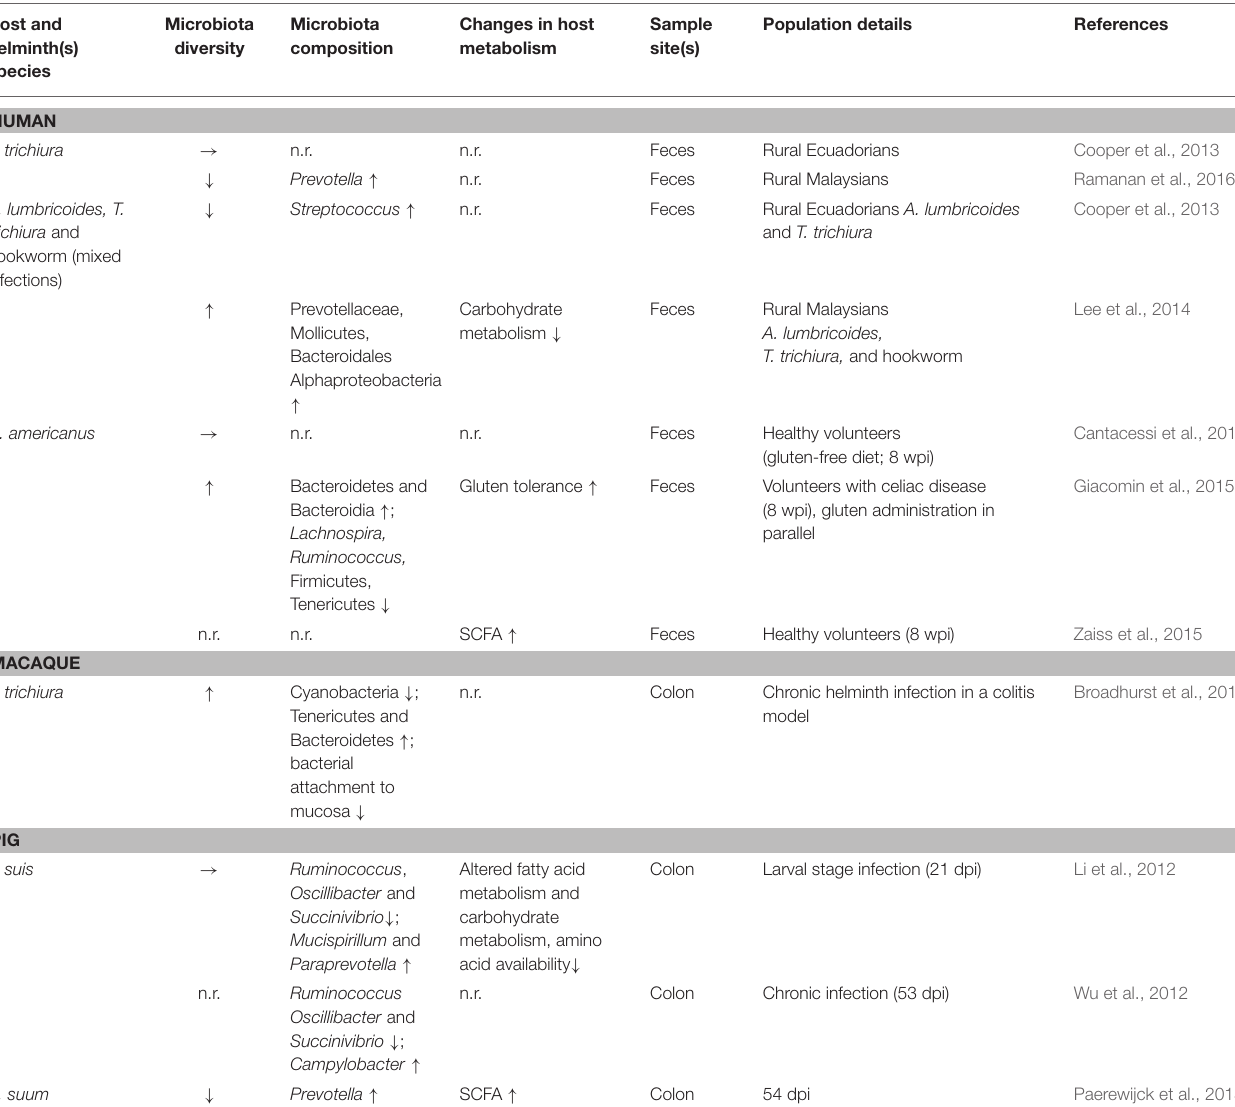
TABLE 1 | Effects of helminth infection on host microbiota and metabolism in humans, macaques, and pigs. Host and helminth(s)